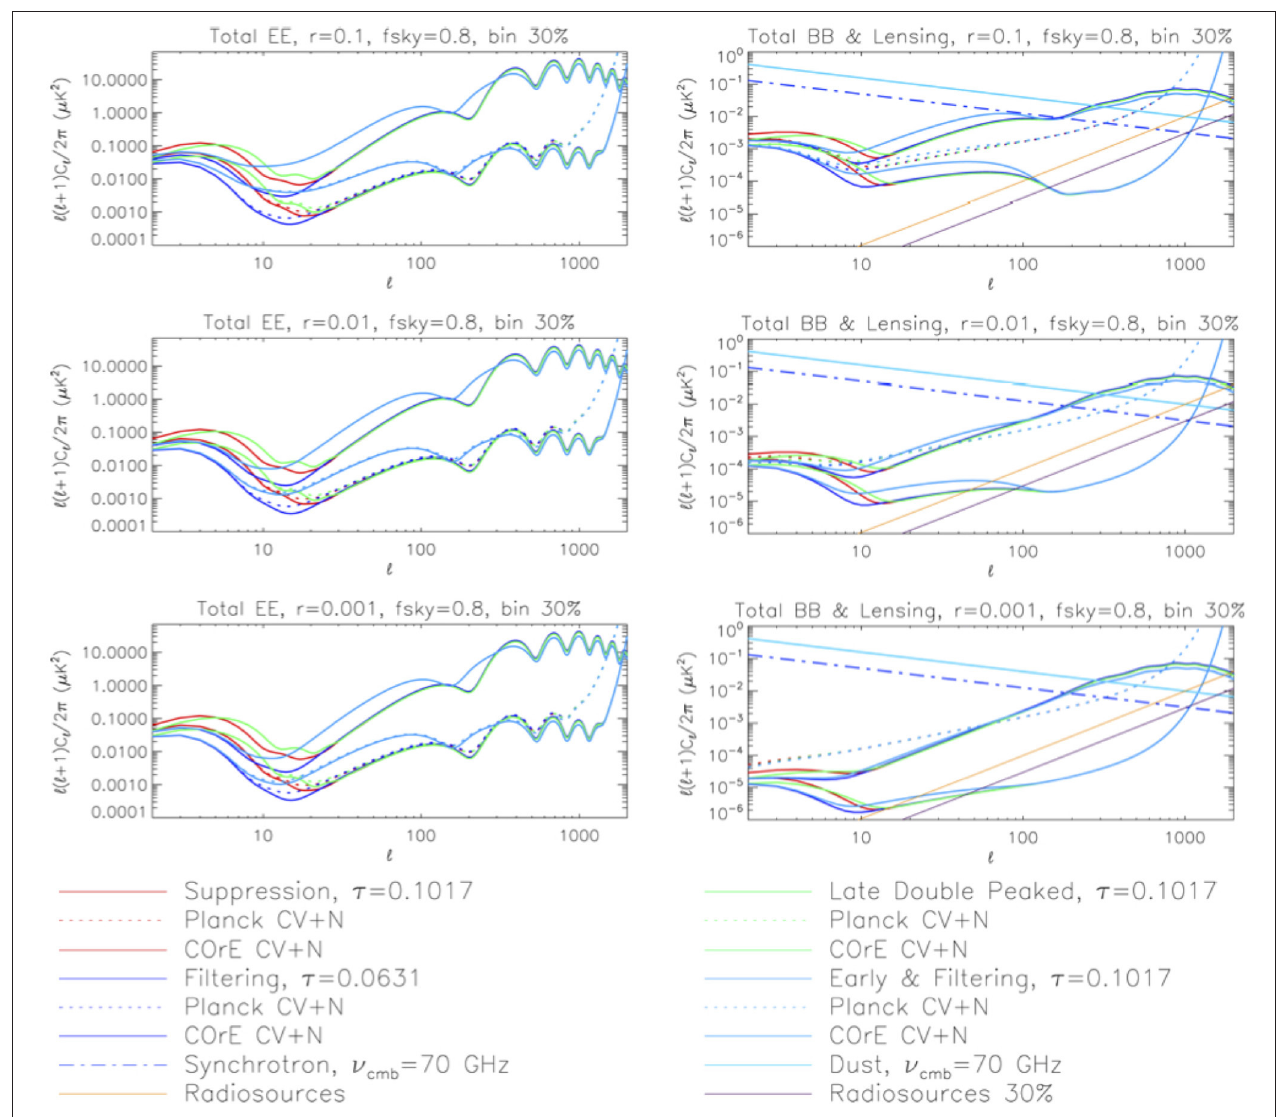
FIGURE 3 | EE and BB “APS for the reionization histories: suppression, filtering, late double peaked, early plus filtering (E+F for z re = 500) for different values of tensor to scalar ratio r .” For the case of BB APS we display also pre- Planck estimates of astrophysical foregrounds: “Galactic synchrotron (dash-dotted blue line) and thermal dust (dash-triple-dotted cyan line) polarized emission, and extragalactic point source fluctuations (solid orange line) and their potential residual (solid violet line).” See plot legend and text for details. Estimates of the overall sensitivity for Planck and COrE missions, including cosmic, sampling variance and noise limitations (CV+N) are also displayed. Reprinted from Trombetti and Burigana